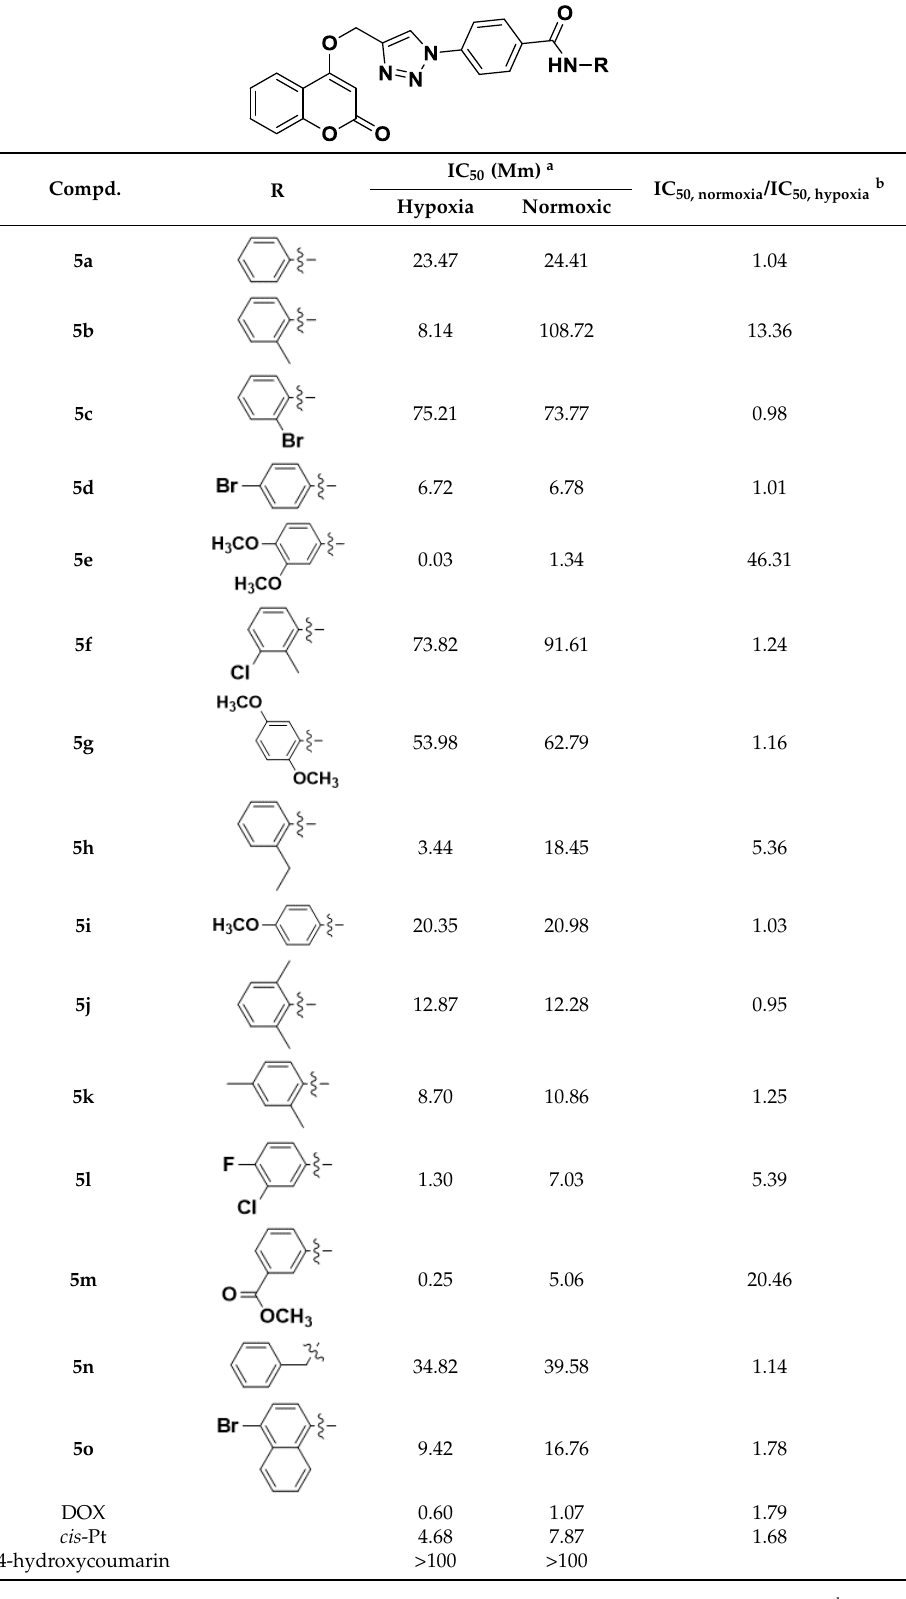
Table 1. IC 50 of the compounds against MDA-MB-231 cell.